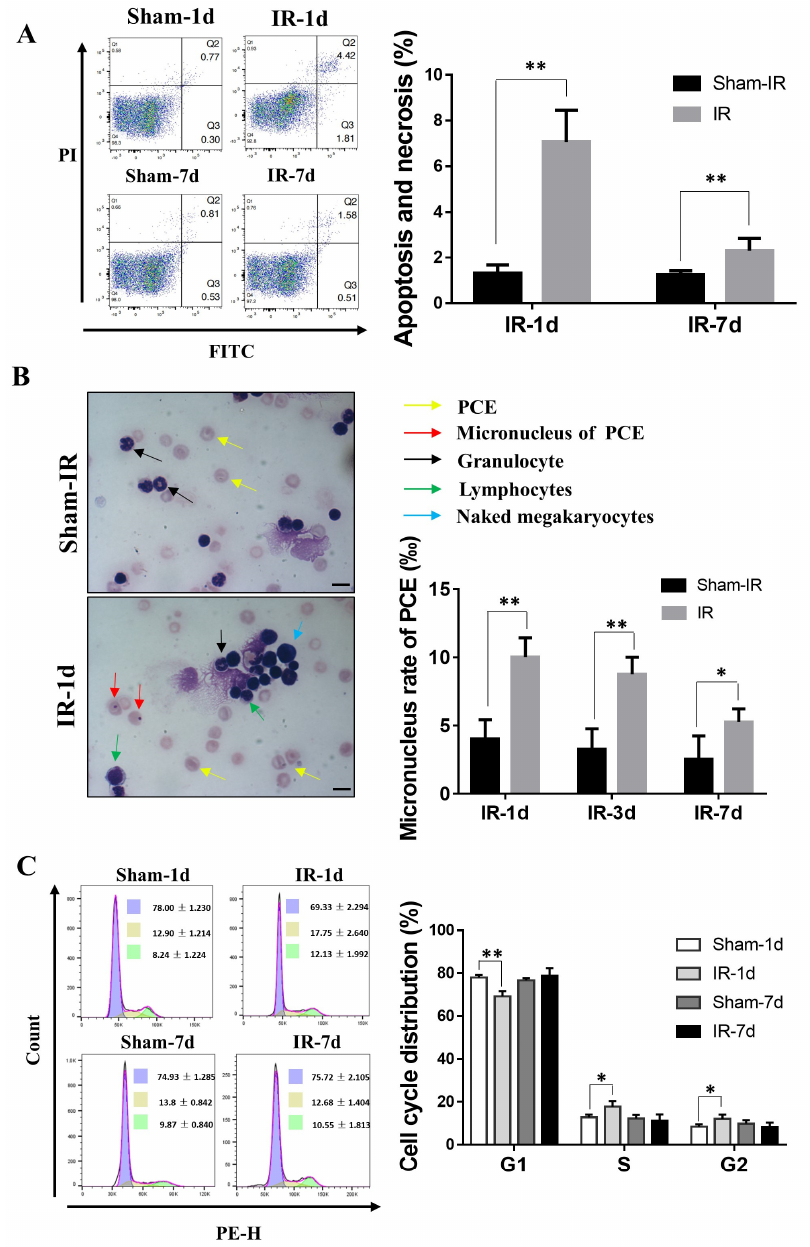
Figure 2. Th-IR induced cellular damage and cell cycle alteration in abscopal bone marrow of mice. ( A ) The bone marrow cell apoptosis and necrosis were enhanced after Th-IR. ( B ) Micronucleus frequency of PCEs was increased after Th-IR. Yellow arrow, PCEs; red arrow, micronucleus of PCEs ( × 1000). Bar = 10 µ m. ( C ) Th-IR decreased the percentage of the bone marrow cells in G1-phase and increased in S- and G2-phase at day 1 after Th-IR. * p < 0.05 and ** p < 0.01 compared with corresponding sham-IR group. n =